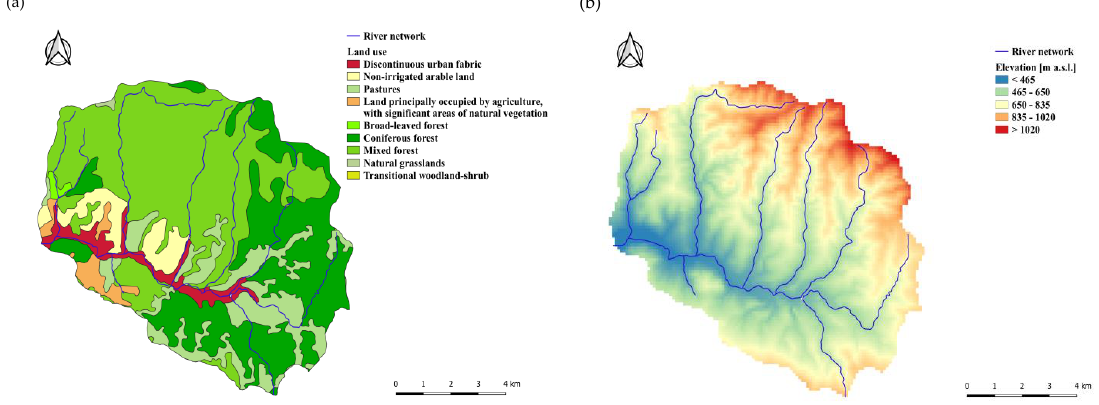
Figure 1. Case study land use ( a ) and topography ( b ).